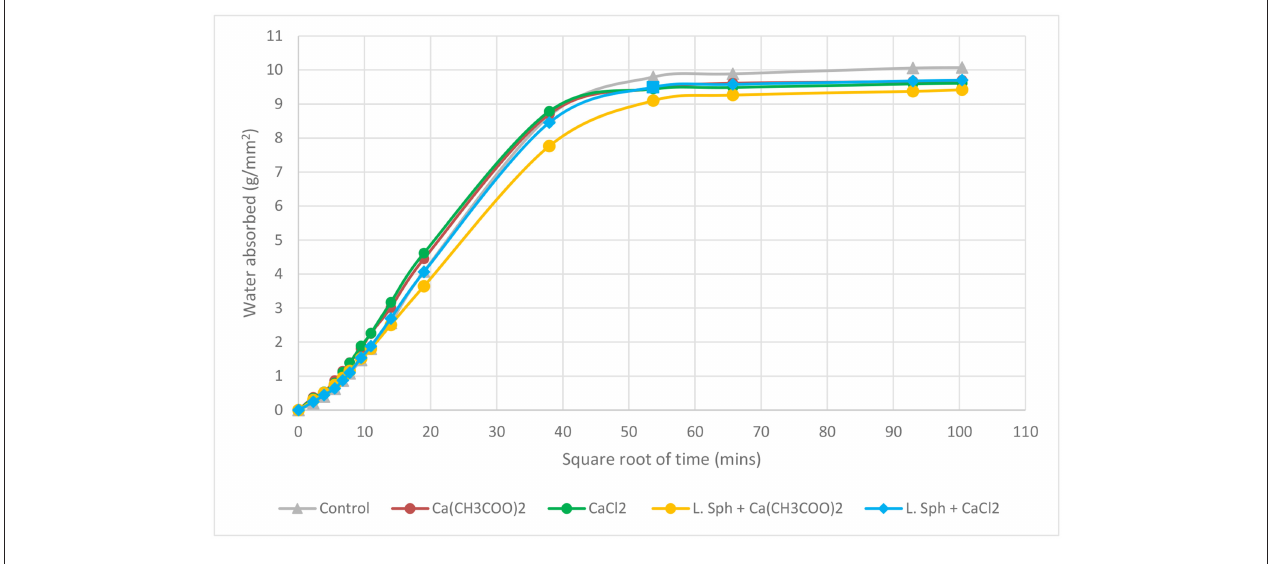
FIGURE 9 | Average water absorption vs. immersion time for uncracked mortar prisms.